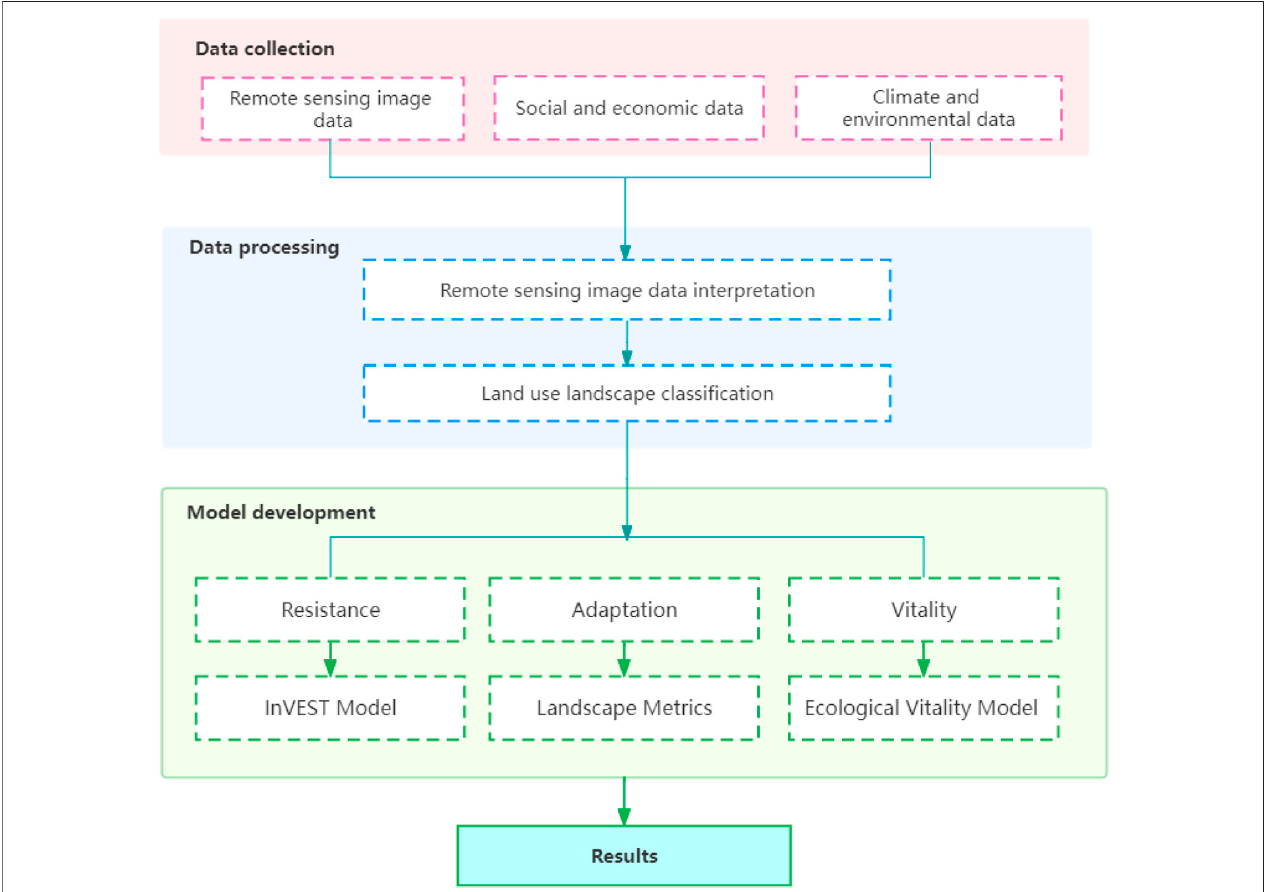
FIGURE 2 | Framework diagram for resilience evaluation of urban ecosystems based on “ resistance-adaptation-vitality. ”